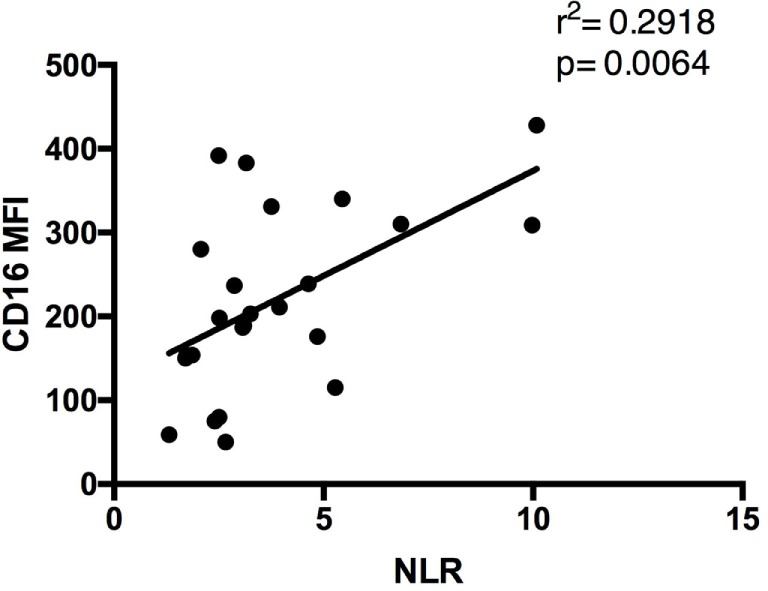
Relationship between CD16 mean fluorescence index (MFI) and neutrophil-to-lymphocyte ratio (NLR) values. Graph showing a positive correlation between CD16 MFI and NLR in patients’ blood samples. Sample size included both day 0 and day 5 findings to show the universal relationship between the parameters tested (n = 24).